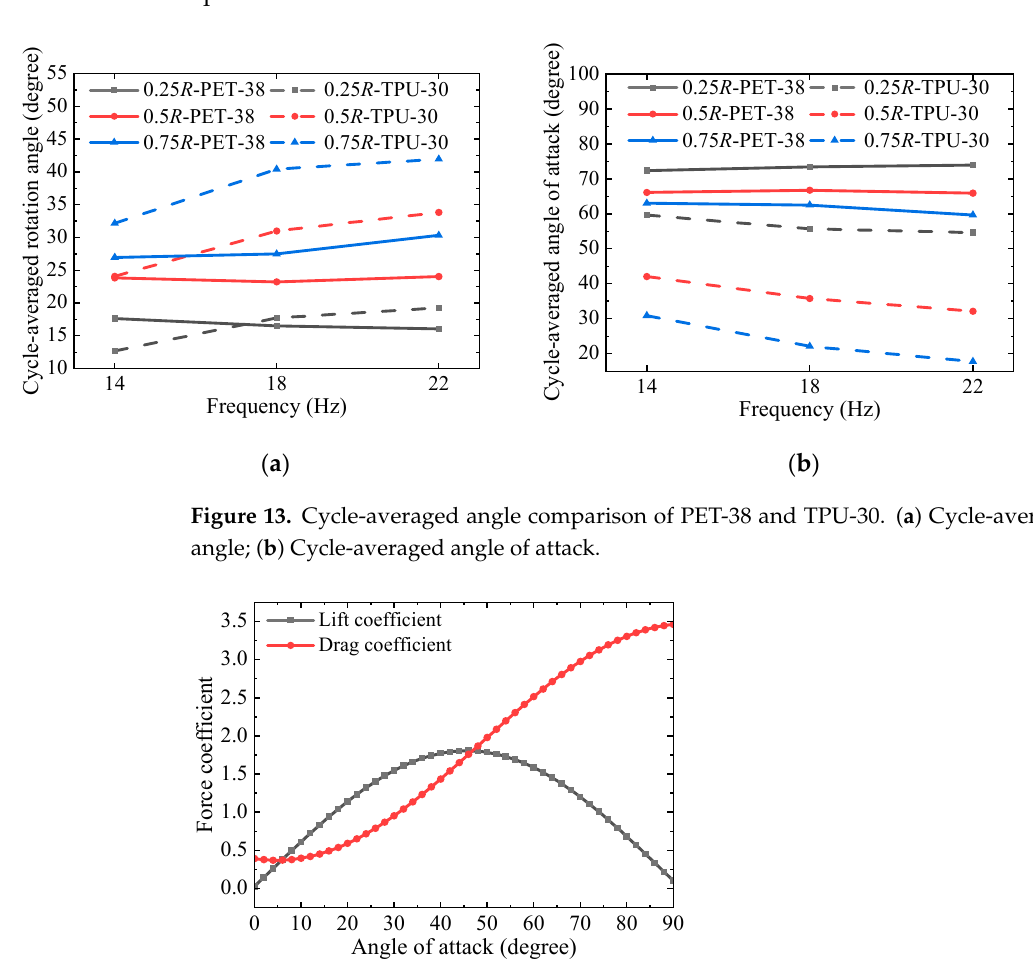
Figure 14. Translational lift and drag coefficients calculated based on the research by Dickinson et al. [1].